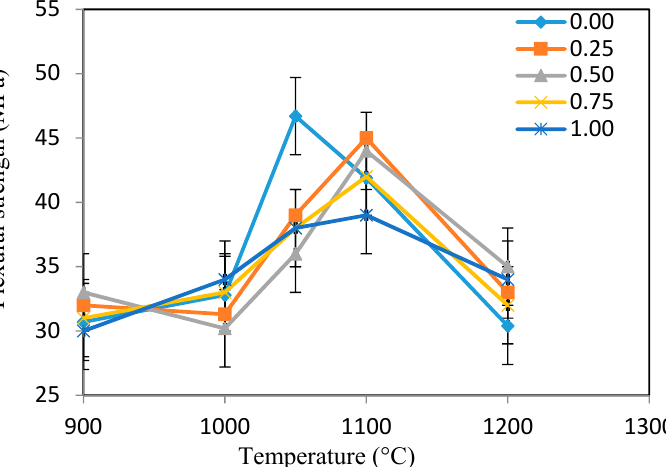
Figure 9. Numerical values of the flexural strength of Ca 10 − x K x (PO 4 ) 6 F (2 − 2 x ) (OH) x for 0 ≤ x ≤ 1 sintered at various temperatures.